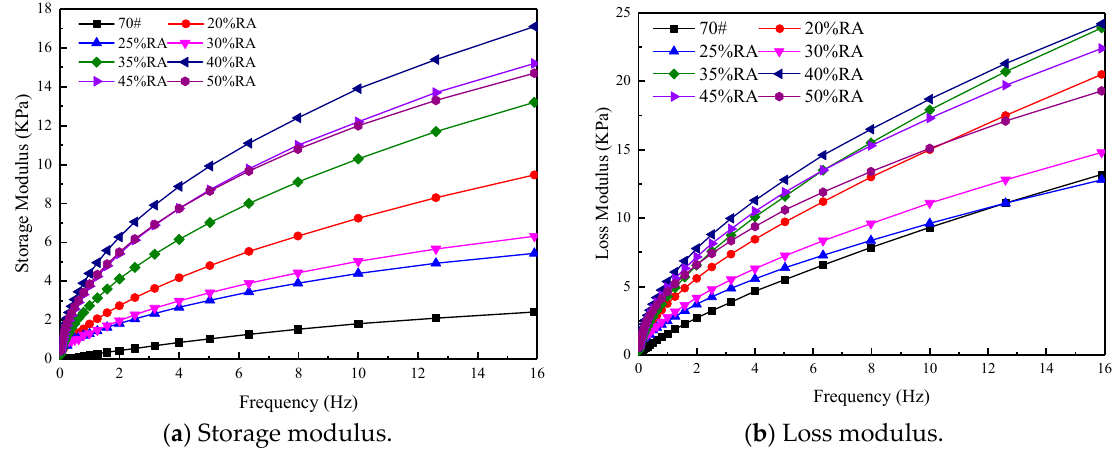
Figure 7. Storage modulus and loss modulus. ( a ) Storage modulus ( b ) Loss modulus.